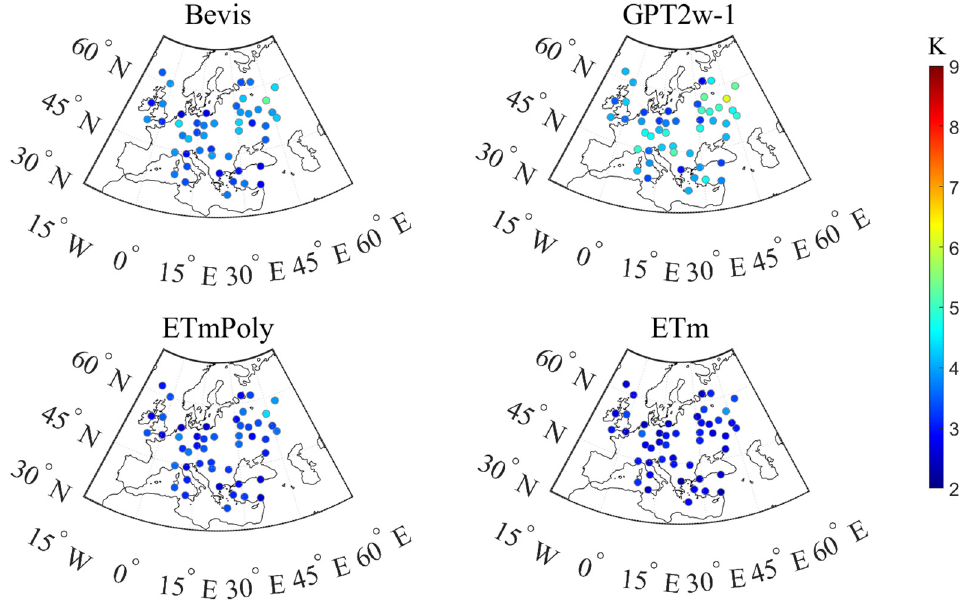
Figure 4. RMS distribution of the four Tm models at each modeling station in 2021 .